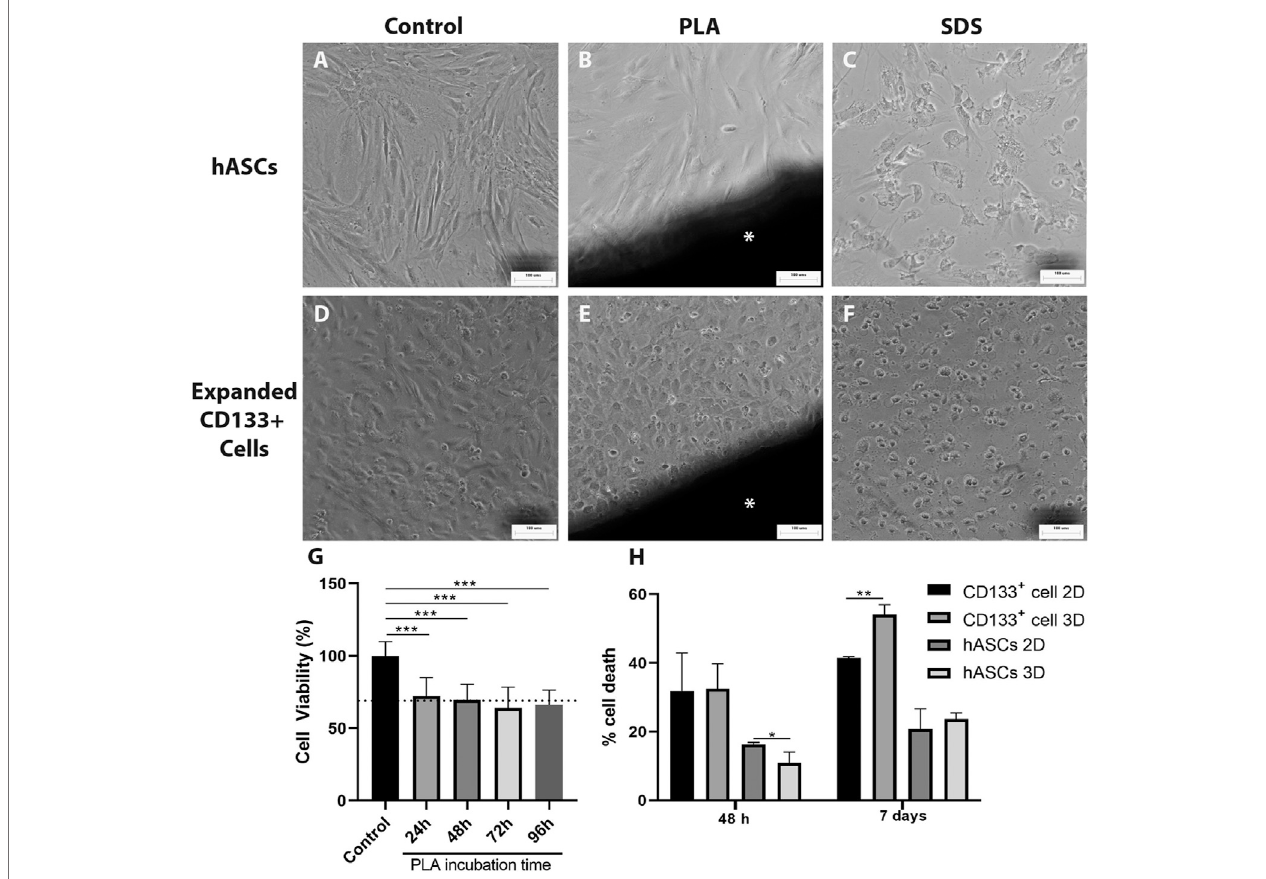
FIGURE 2 | Cytotoxicity evaluation of the PLA scaffolds. Cytotoxicity was measured using direct contact (A – F) and NRU assays (G) . The images on the far left illustrate hASCs morphology (A) on the negative control of the direct contact assay (B) cultured with a fragment of the PLA scaffold and (C) cultured with SDS. The next three pictures illustrate the expanded CD133 + cell morphology (D) on the negative control of the direct contact assay (E) cultured with a fragment of the PLA scaffold and (F) cultured with SDS. Scale bar (cid:1) 100 μ m *PLA fragment (G) Cytotoxicity of the PLA scaffold observed on the NRU assay. BalB/c3T3 cells were cultured for 48 h with PLA extracts collected after 24, 48, 72 and 96 h ofincubation. Cytotoxicity is represented by cell viability calculated asexplained in the materials and methods section. Thedotted linerepresents aRGRof70%. One-way ANOVA analysis: *** p ≤ 0.001. n (cid:1) 2 (H) PLAscaffoldscytotoxic potentialevaluated byspectrophotometric LDH assay after 48 h and 7 days of culture. Student ’ s unpaired t-test analysis: * p ≤ 0.05 ** p ≤ 0.01 ( n (cid:1) 3).